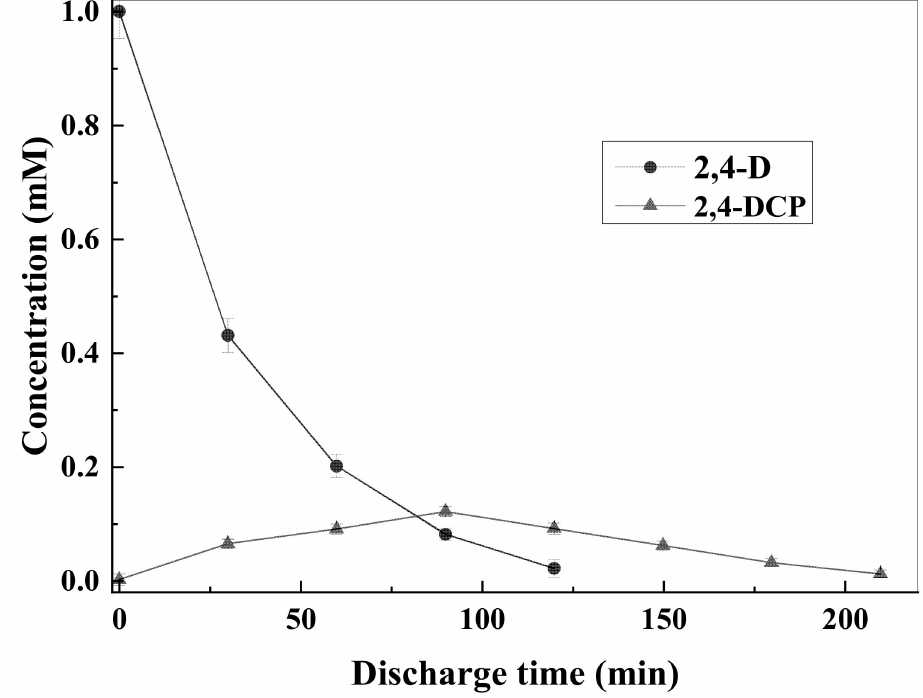
Figure 10. Appearance and decay profile of 2,4-DCP during RFD (input power, 200 W; [2,4-D] 0 , 1.0 mM; pH 0 ,